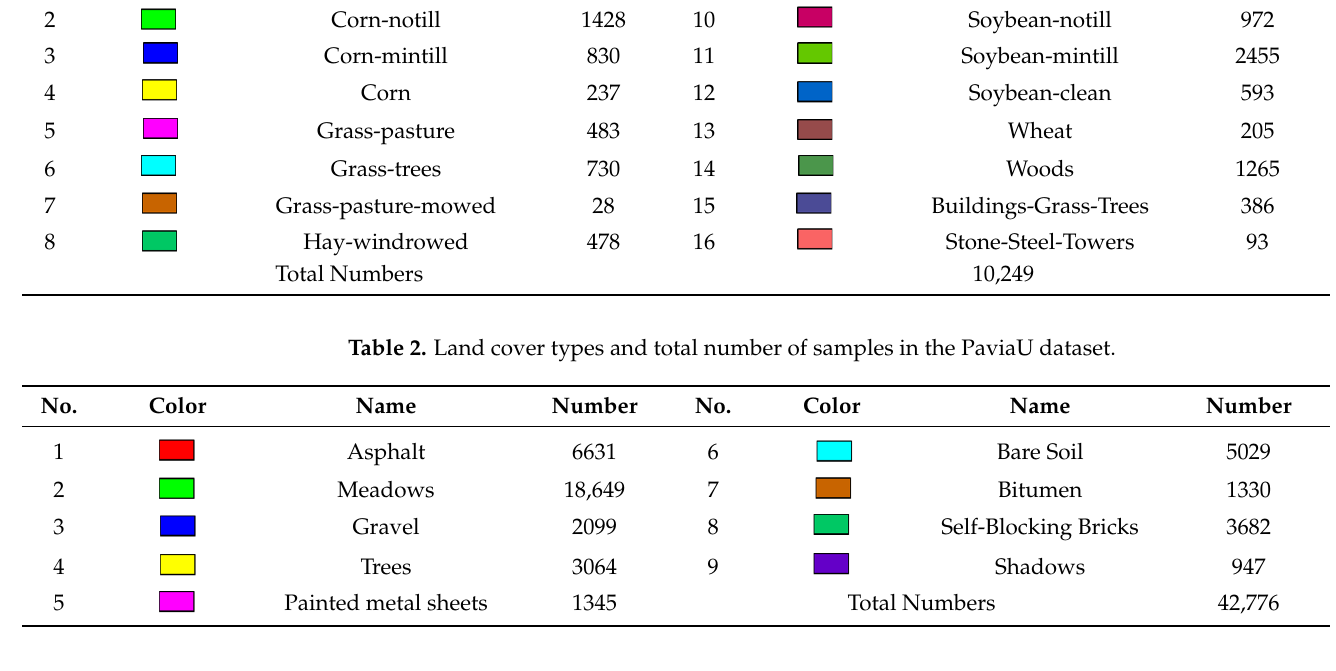
Table 1. Land cover types and total number of samples in the Indian Pines dataset.